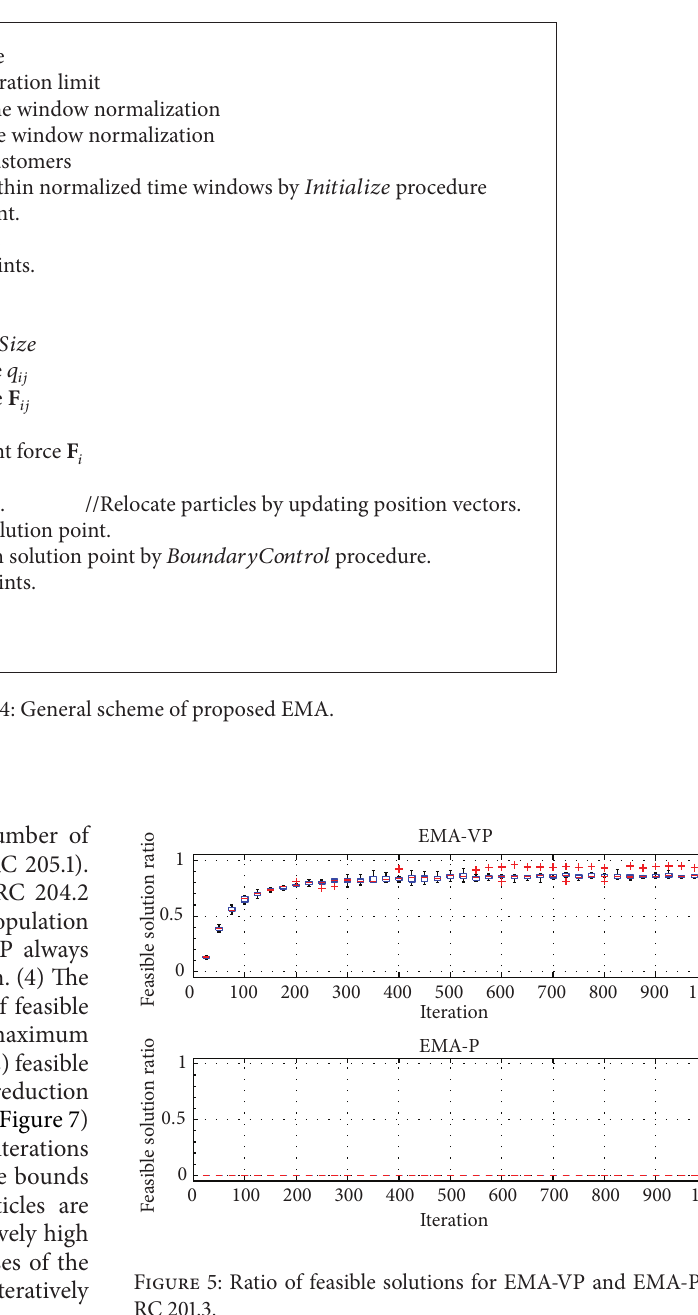
Figure 5: Ratio of feasible solutions for EMA-VP and EMA-P for RC